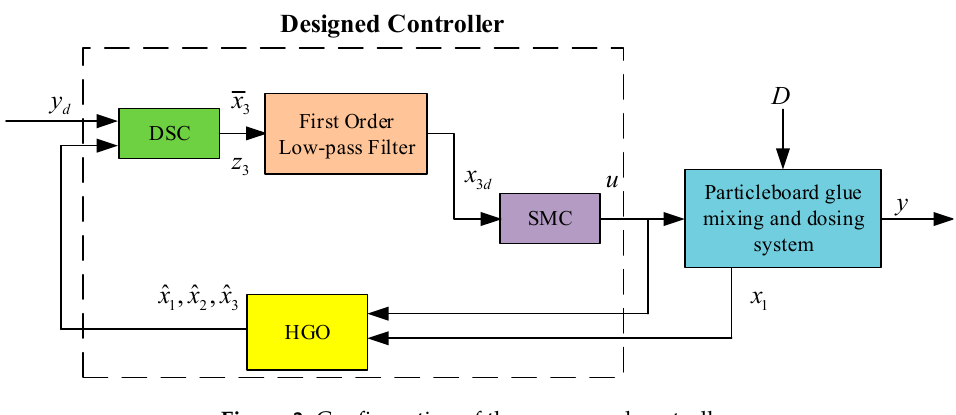
Figure 3. Configuration of the compound controller.